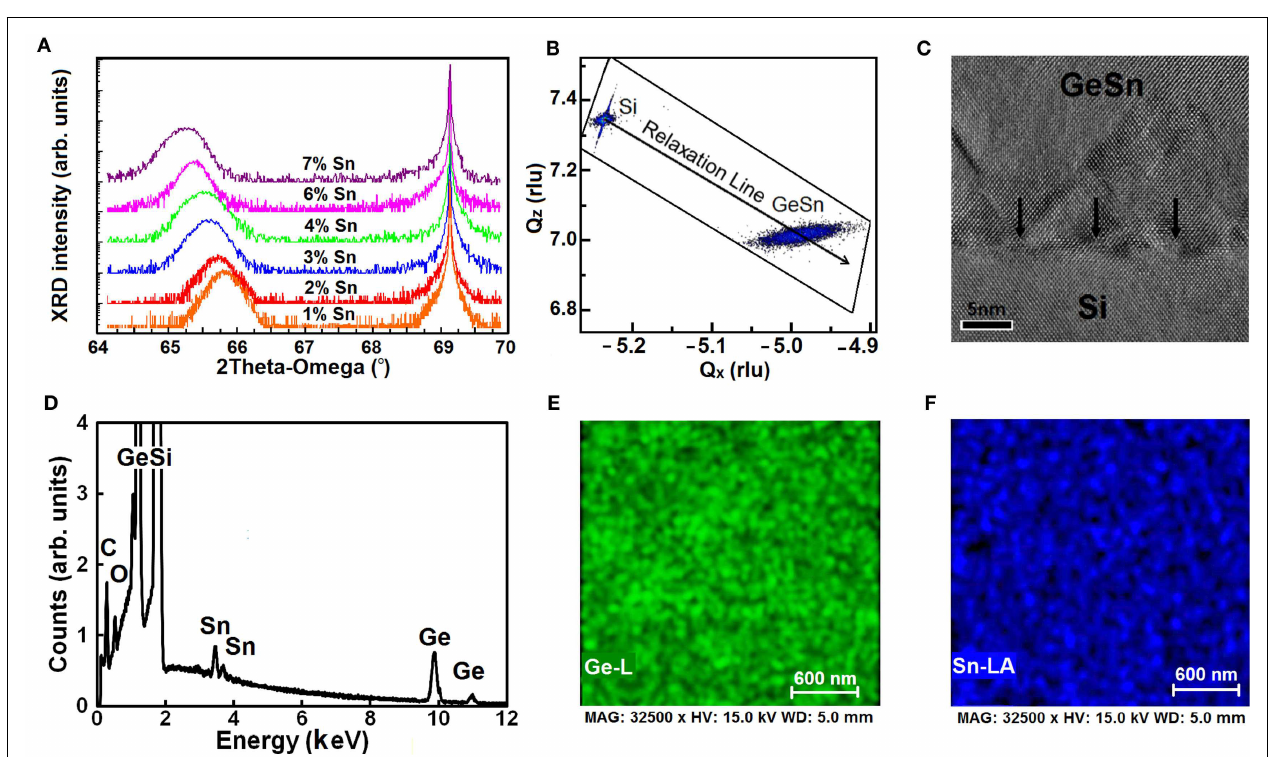
Ge 0.94 Sn 0.06 on the relaxation line shows that the film is strain relaxed. (C) Transmission electron microscopy images of Ge 0.94 Sn 0.06 film shows epitaxial growth of Ge–Sn on a Si substrate. Arrows show misfit dislocations formed at the Ge 1 − x Sn x /Si interface. (D) The EDX spectrum of Si/Ge 0.94 Sn 0.06 film shows the presence of Si (substrate), Ge and Sn (film), O (native oxide), and C (carbon contamination from the ambient). (E) The EDX surface maps of Ge and (F) Sn taken from scanning electron micrographs for Ge 0.94 Sn 0.06 film shows uniform growth of Ge 1 − x Sn x alloy.